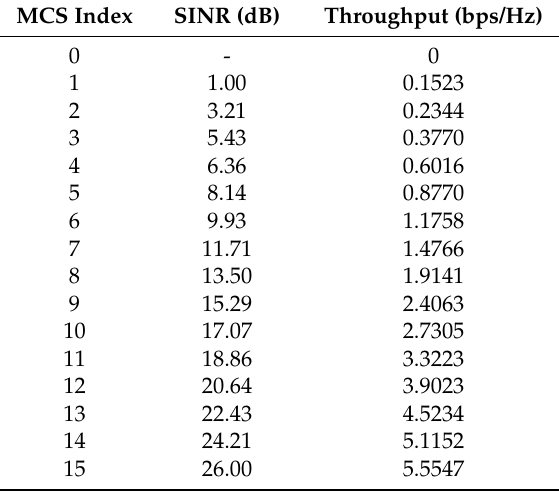
Table 3. Achievable throughput for signal-to-interference plus noise power ratio